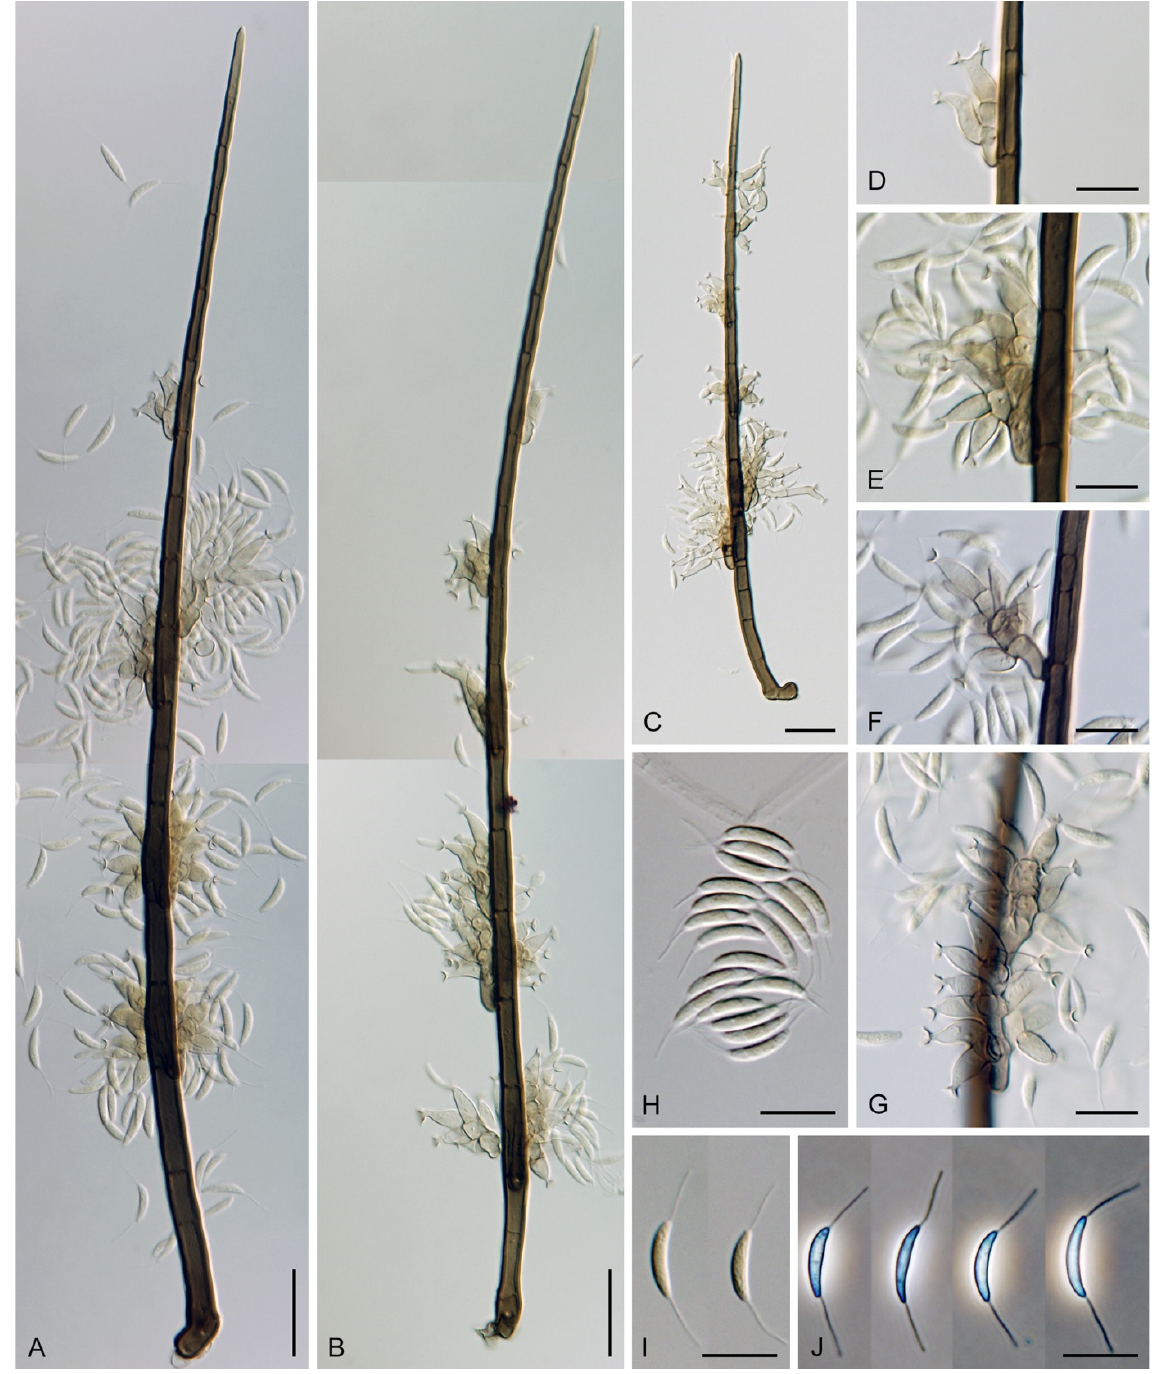
Figure 10. Codinaea amazonensis (MUCL 41171). ( A – C ) Conidiophores ( D – G ) conidiogenous cells ( H – J ) conidia. Images: ( A – J ) on MLA after 4 weeks. Scale bars: ( A – C ) 20 μ m; ( D – J ) 10 μ m.